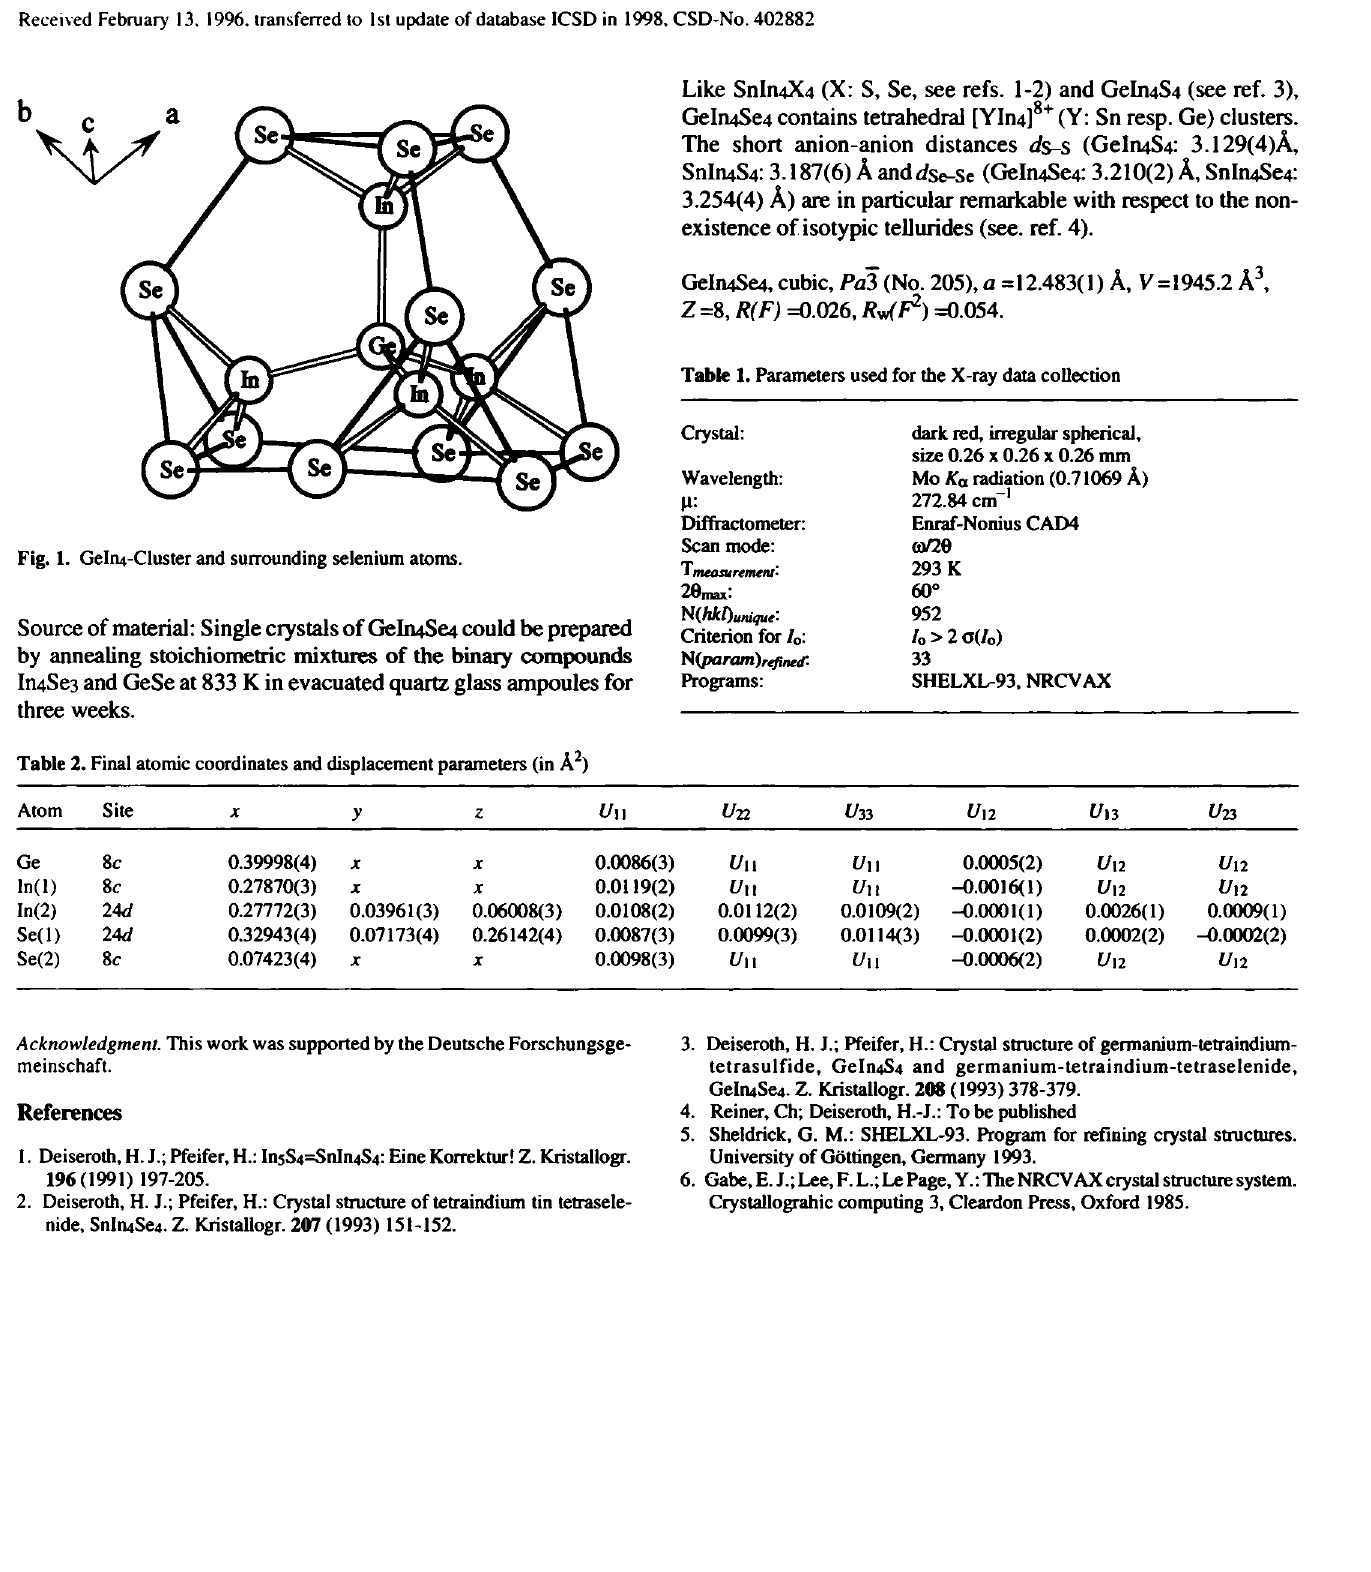
Table 1. Parameters used for the X-ray data collection